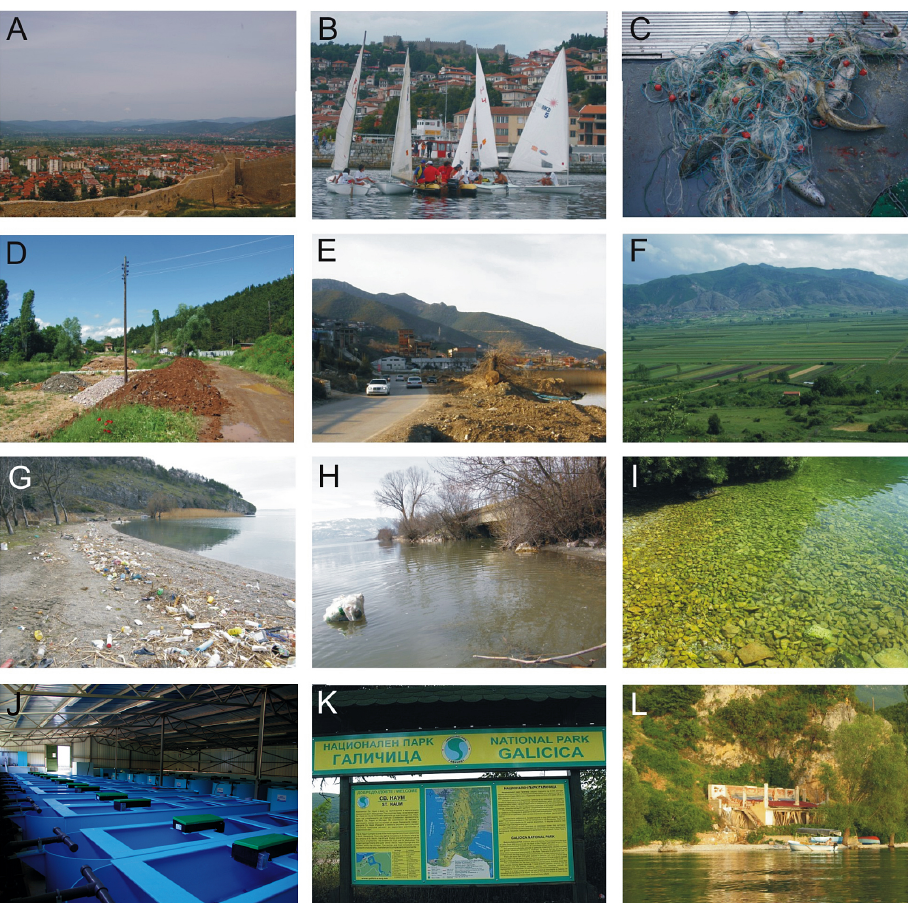
Fig. 2. Examples of threats facing Lake Ohrid and conservation activities. (A) – Urban and rural expansion in the Ohrid basin, Ohrid town; (B) – increasing boat traffic on the lake; (C) – overexploitation of fisheries, illegal net fishing on Macedonian side; (D) –